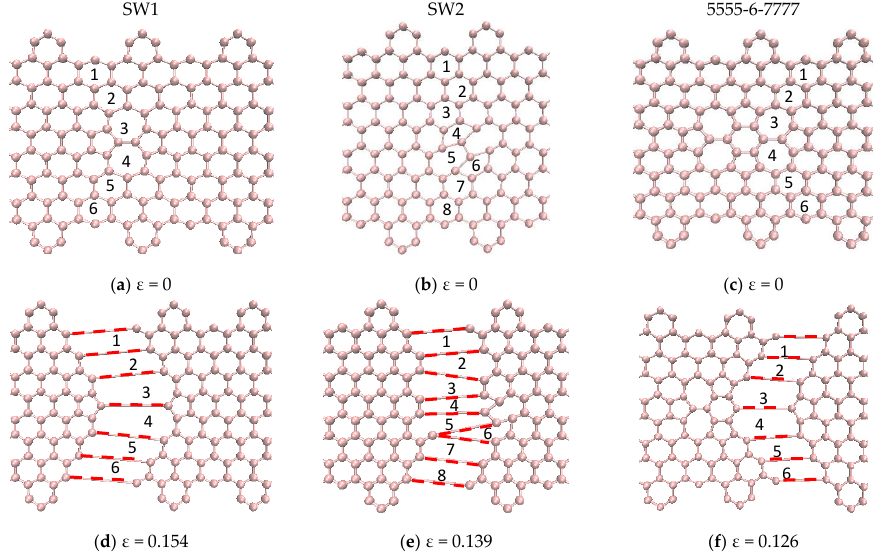
Figure 10. Failure patterns and related atoms and bonds of SW1, SW2 and 555-6-777 defects.